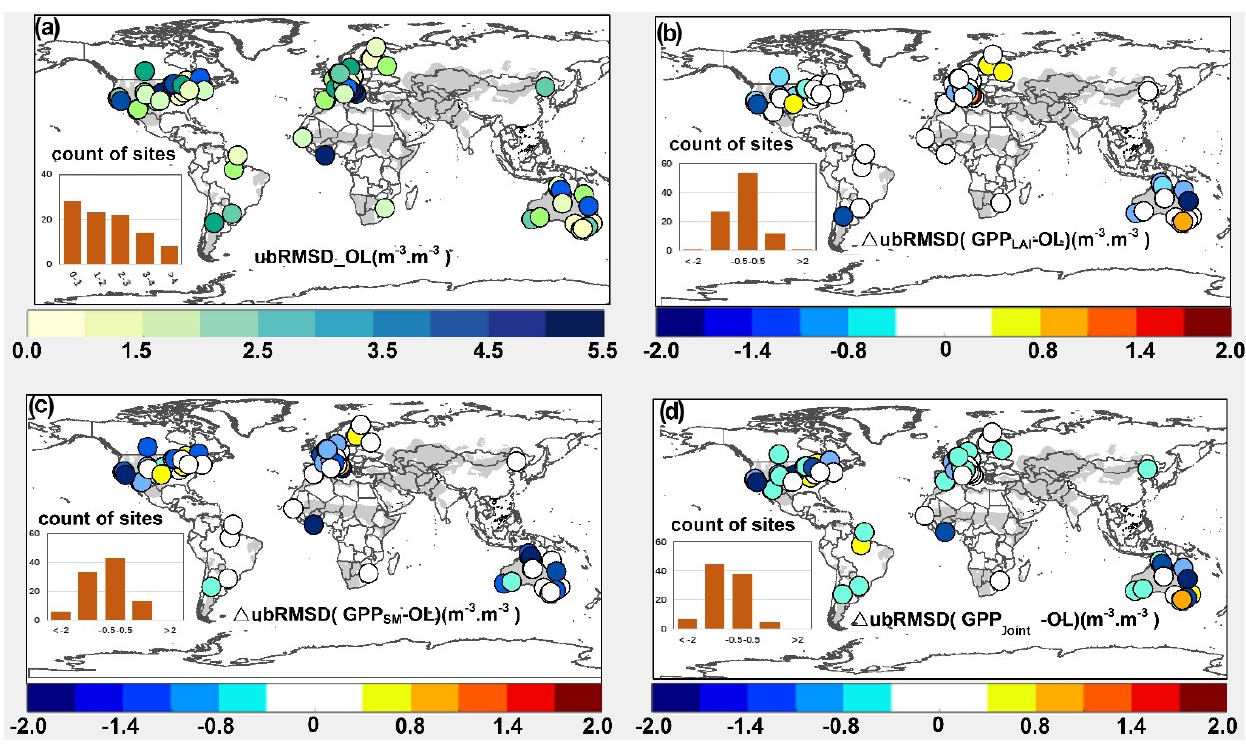
Figure 2. (a) The unbiased root mean square error (ubRMSD) between the GPP LPJ and the site observations, with yellow/blue indicating low/high ubRMSD. (b) (cid:49) ubRMSD (GPP LAI –GPP LPJ ). (c) (cid:49) ubRMSD (GPP SM –GPP LPJ ). (d) (cid:49) ubRMSD (GPP Joint –GPP LPJ ). Blue/red represents positive/negative